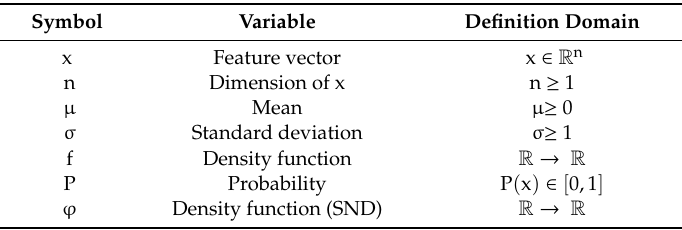
Table A3. Overview of the variables used in the probabilistic